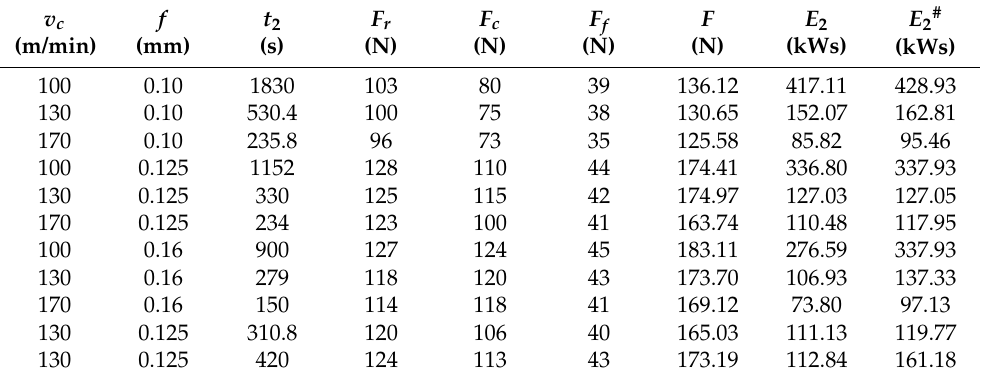
Table 4. Experimental results for cutting force and machining energy. (Note: v c is cutting speed, f